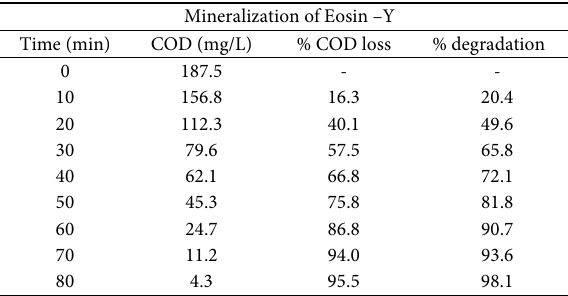
Fig. 8 Effect of pH on the degradation of EY. Fig. 8: Effect of pH on the degradation of EY. Catalyst= 10 % GO – nanotitania, Catalyst load = 8 mg, [EY]=2.33 x 10 -5 M, Volume=100 mL. Table 3. COD studies of EY using 10 % GO – NT composite Table 3. COD studies of EY using 10 % GO – NT